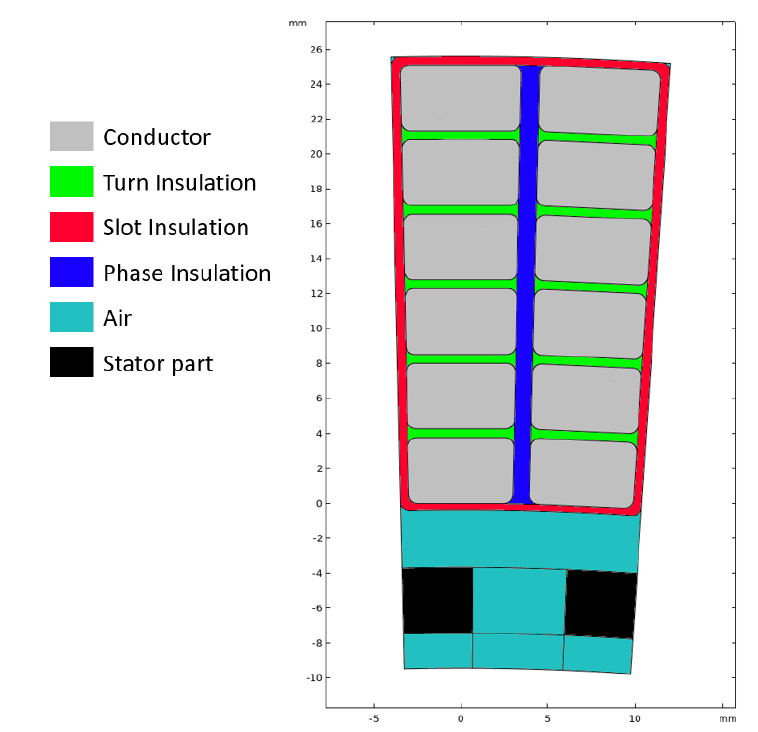
Figure 7. Drawing of the slot cut-through with windings of different phase. Turn-to-turn (green), phase-to-ground (red) and phase-to-phase (blue) insulation are indicated around the turns of the windings (grey).